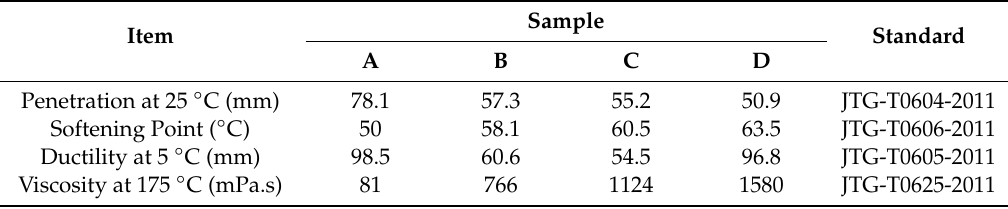
Table 4. The conventional physical parameters of asphalt